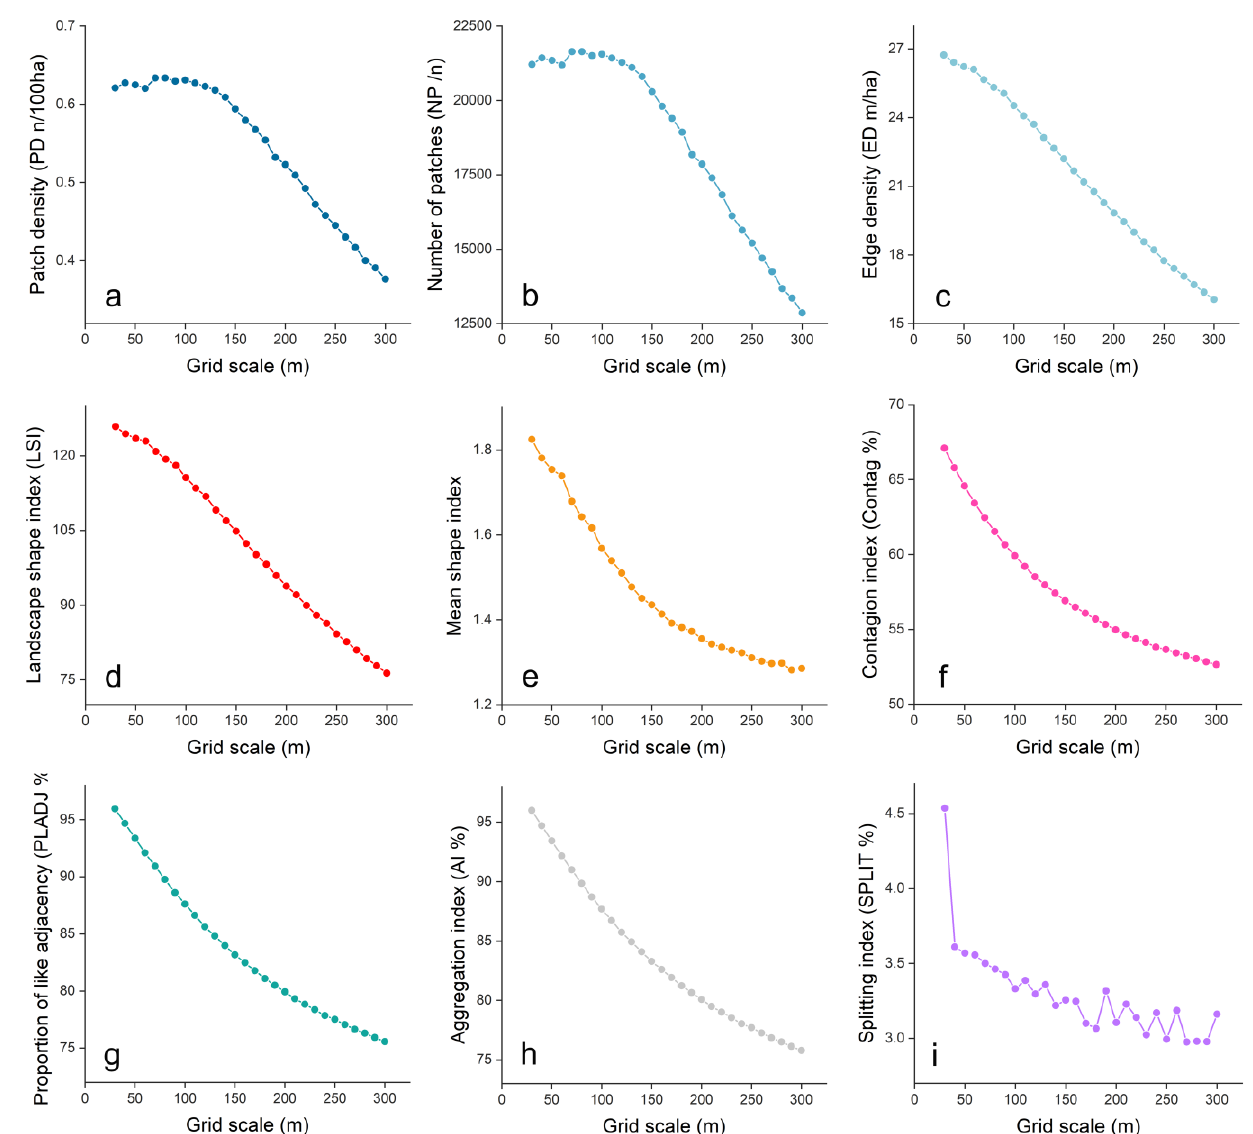
Figure 2. Change trend of the sensitive landscape index with granularity at the landscape level on Hainan Island. ( a ) Change trend of PD with granularity. ( b ) Change trend of NP with granularity. ( c ) Change trend of ED with granularity. ( d ) Change trend of LSI with granularity. ( e ) Change trend of SHAPE-MN with granularity. ( f ) Change trend of CONTAG with granularity. ( g ) Change trend of PLADJ with granularity. ( h ) Change trend of AI with granularity. ( i ) Change trend of SPLIT with granularity.